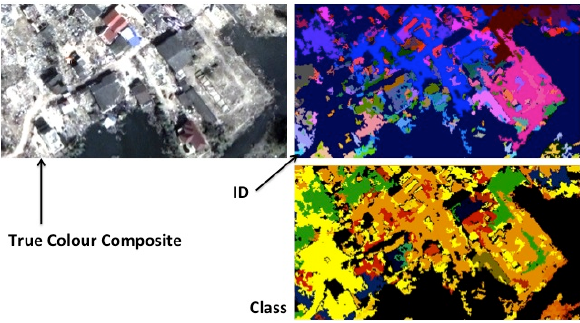
Figure 5. Fine level processing results of a damage area